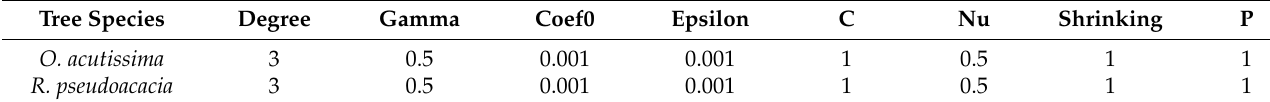
Table 5. Model parameters of SVM.